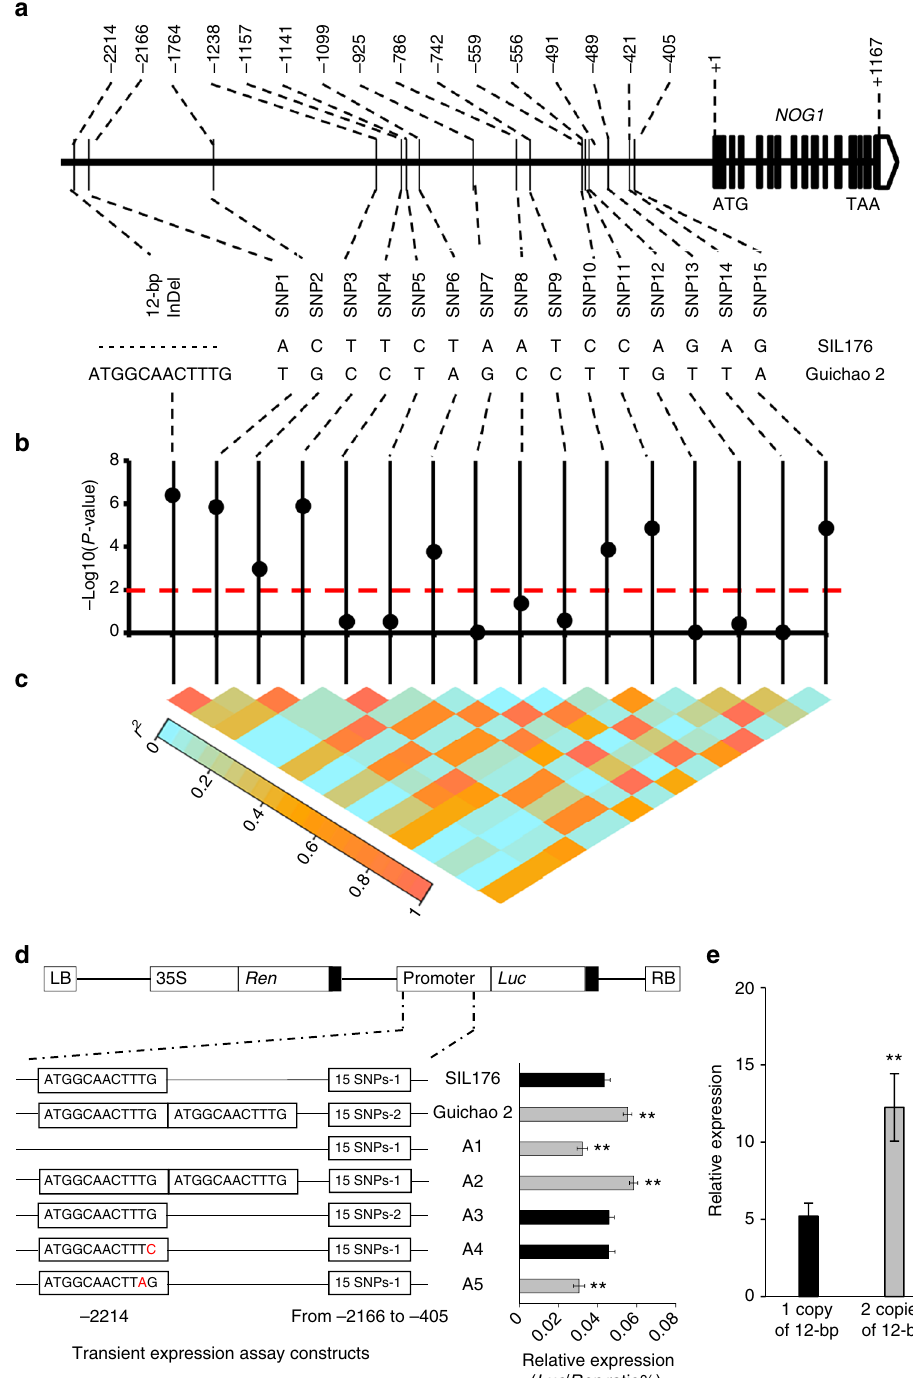
Fig. 4 Association test and expression pro fi le of NOG1 variation. a Sequences comparison of a promoter region between SIL176 and Guichao 2. b Association testing with grain number per main panicle of 16 variants in the 4.3-kb fi ne-mapping region. Black dots represent 16 variations. c Triangle matrix of pairwise linkage disequilibrium. d Effect of the 12-bp insertion and 15 SNPs in NOG1 promoter by transient expression assays. Above, constructs of pGreenII 0800- LUC vector. Left, constructs with site-directed NOG1 promoter. SIL176 and Guichao 2 de fi ne the constructs with the ~2500-bp promoter fragments from SIL176 and Guichao 2, respectively. The SIL176 promoter contained one copy of the 12-bp and the 15 SNPs-type 1 (ACTTCTAATCCAGAG). The Guichao 2 promoter contained two copies of the 12-bp and the 15 SNPs-type 2 (TGCCTAGCCTTGTTA). A1, A2, and A3 de fi ne constructs with site- directed mutations at the 12-bp InDel (positions − 2214) and 15 SNPs (positions from − 2166 to − 405) in the SIL176 promoter fragment, respectively. A4 and A5 de fi ne constructs with site-directed mutations at TBOXATGAPB and DOFCOREZM TFBS on the 12-bp InDel in the SIL176 promoter fragment, respectively. Right, expression levels of fi re fl y luciferase relative to Renilla luciferase ( n = 10). e Comparison of NOG1 gene expression levels between varieties containing one copy of 12-bp and varieties containing two copies of 12-bp ( n = 20). Data are means, with error bars showing SEM (two-tailed Student ’ s t test; ** P <